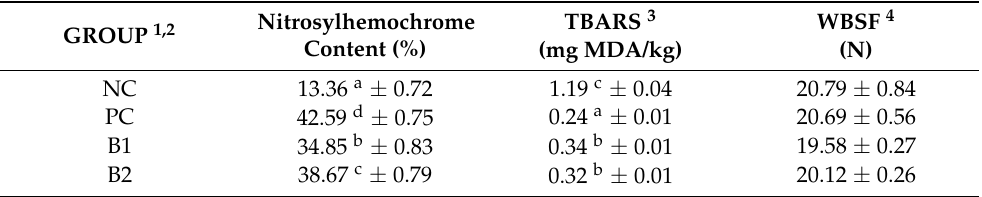
Table 2. The effect of alternative nitrite sources on nitrosylhemochrome content, thiobarbituric acid reactive substances values, and Warner-Bratzler shear force (mean ± SE) of cured pork loin (n =